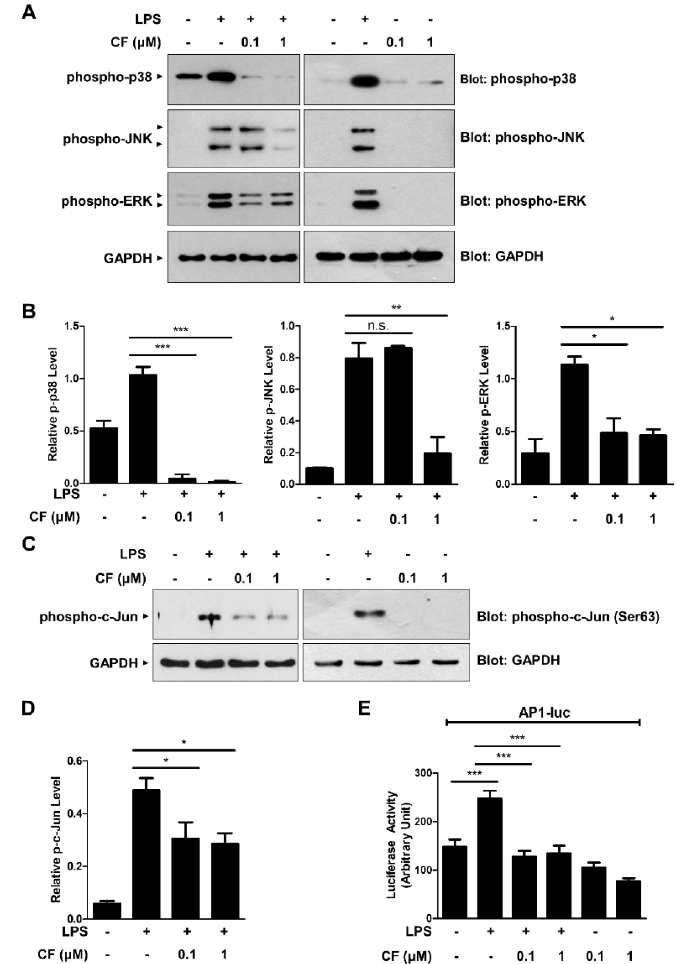
Figure 3. CF regulates the MAPK/AP-1 signaling pathway. ( A – D ) RAW264.7 macrophage cells were treated with CF (0.1 and 1 µ M) for 30 min before treatment with LPS (500 ng/mL). After 6 h, the cell lysates were subjected to immunoblotting with the indicated antibodies ( A , C ) and then quantified ( B , D ). ( E ) RAW264.7 macrophages were transfected with the AP-1-luc reporter. After 24 h, the cells were pretreated with CF (0.1 and 1 µ M) for 30 min before LPS (500 ng/mL) treatment for 6 h, and luciferase activities in the cell lysates were measured. The results are plotted as the mean ± SD of three individual experiments. * p < 0.05; ** p < 0.01; *** p < 0.001; n.s.,